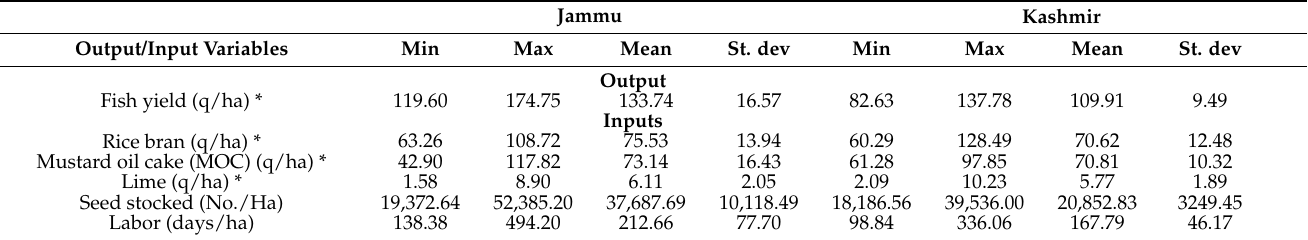
Table 3. Statistics of exotic carp outputs and inputs used in the